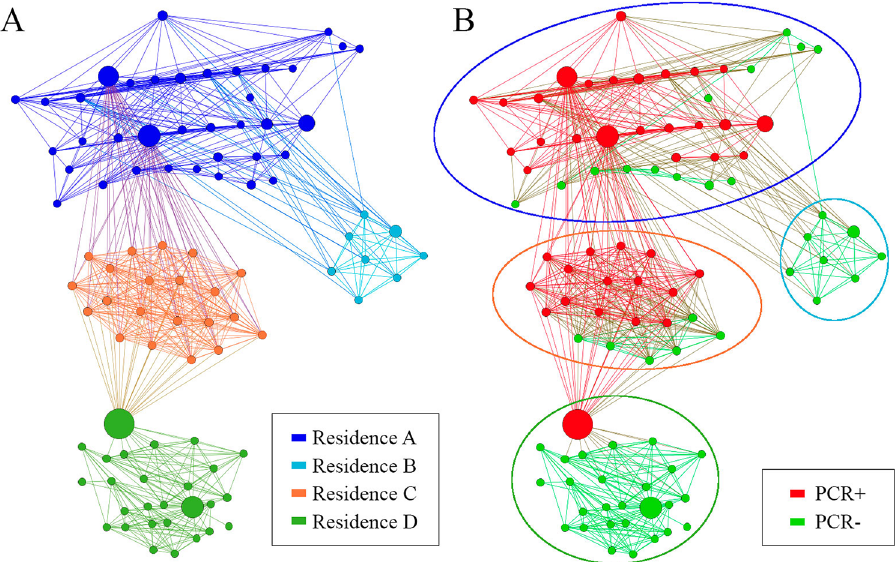
Figure 1. Graphs of the university student network differentiating a colour for each residence hall ( A ) and differentiating the positive and negative PCR groups ( B)